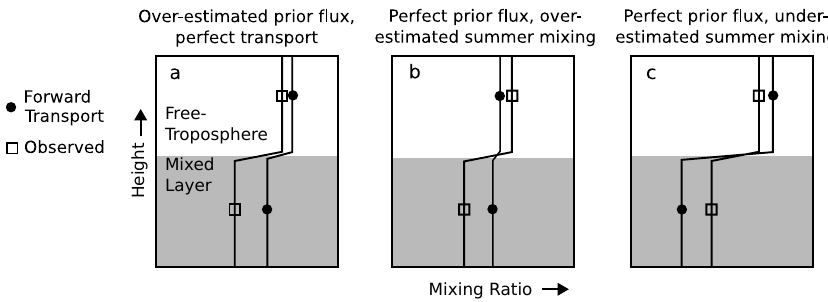
Fig. 9. Panel (a) : Schematic illustrating a hypothetical perfect summer transport model simulation (solid circles) forced with either summer overestimated continental mixed-layer concentrations or overestimated prior surface flux, and the observed free-troposphere and mixed layer concentrations (squares). Panel (b) : as in (a) but for a hypothetical transport model simulation having correctly specified prior surface fluxes but overestimated vertical mixing. Panel (c) : as in (b) but for underestimated vertical mixing. The mixed layer is indicated in gray shading.